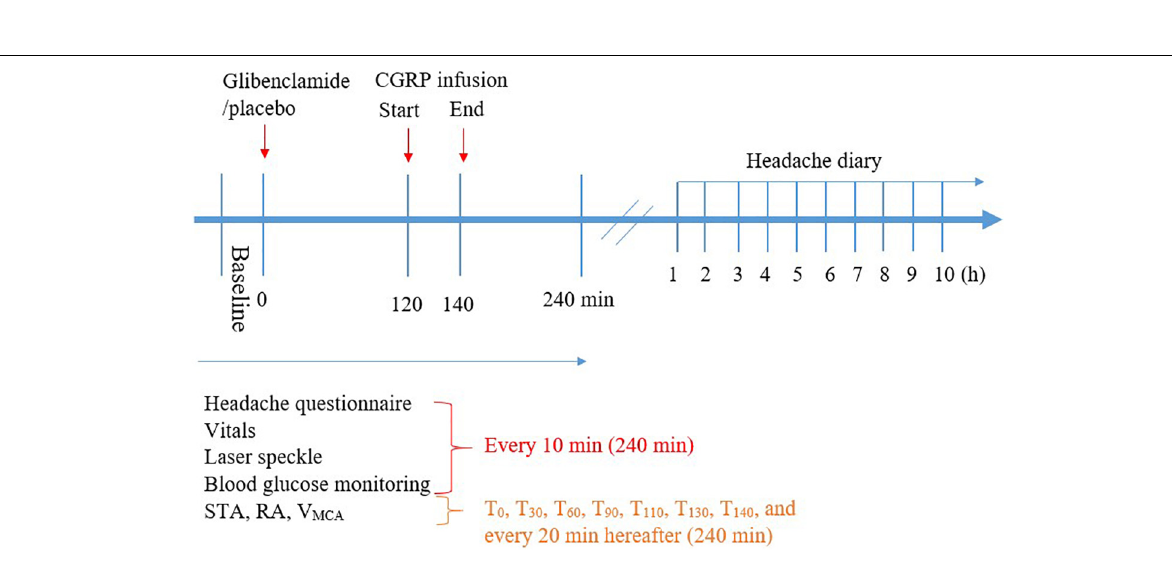
FIGURE 2 | Timeline of the procedure during hospital phase (0–240 min) and post-hospital phase (1–10 h).